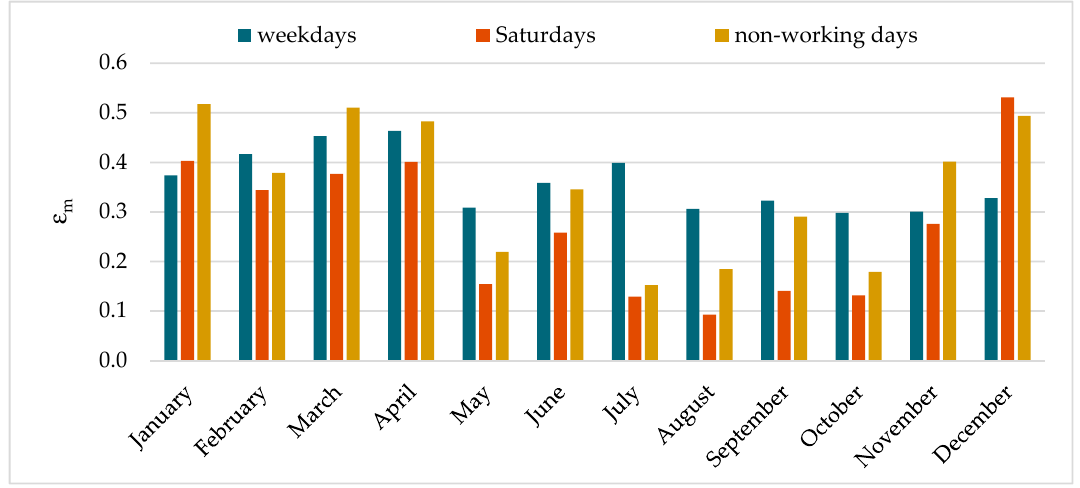
Figure 20. Strategy effectiveness sorted by month and day typologies.